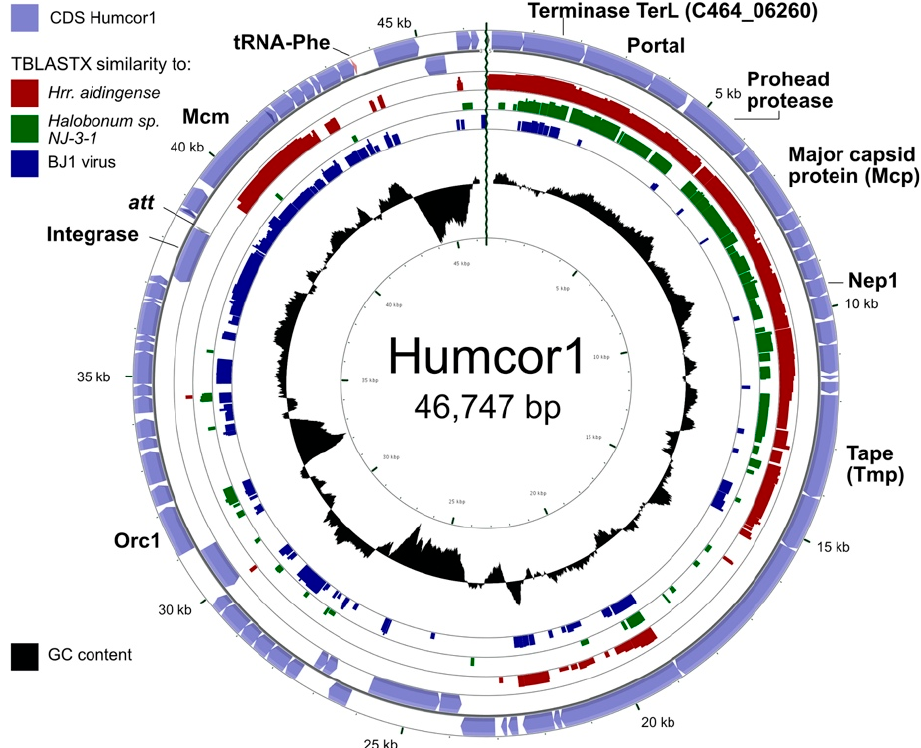
Figure 7. Provirus Humcor1 compared to provirus elements of Hrr. aidingense (AOJI01000015, contig_15, nt 8804–39413), Halobonum sp. NJ-3-1 (CP058579, nt 3124623–3124210) and halovirus BJ1 (AM419438). The outer, light blue rings show the annotated CDS of Humcor1, with the coding strand indicated by the arrow direction. The predicted protein products of several genes are given, with names shown next to their encoding gene. For more details see the text. Similarity (tBLASTx; E-value ≤ 10 − 10 ) to the two proviruses and halovirus BJ1 are shown as inner, coloured rings, with the colour key displayed at the top left. Below the similarity rings is a plot of GC content (black), with higher than average GC content depicted as outward pointing peaks, and lower than average GC content as inwardly pointing peaks. The scale, in kb, is shown at the outer perimeter.